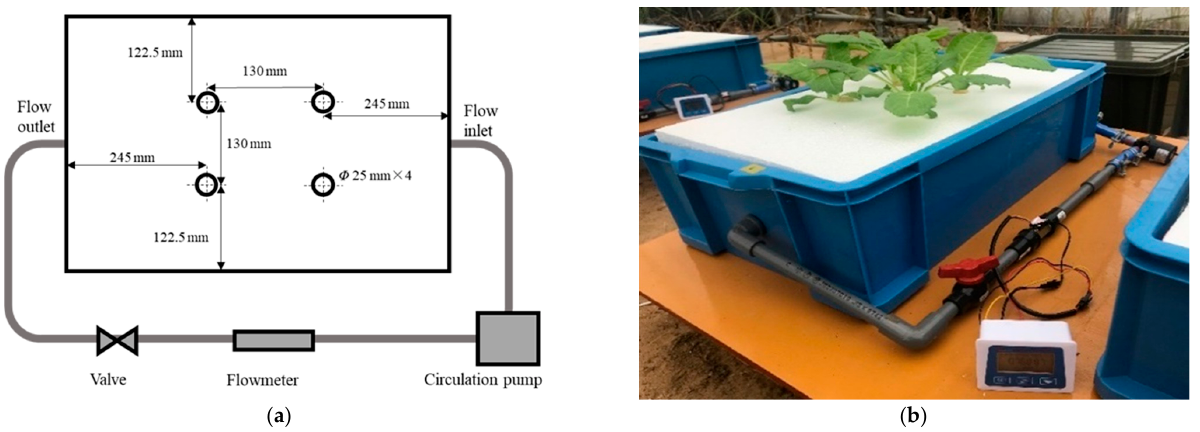
Figure 1. Solar irradiance and ambient temperature of the greenhouse during hydroponic cultivation. Table 1. Composition and concentration of the standard nutrient solution OTA fertilizer A.